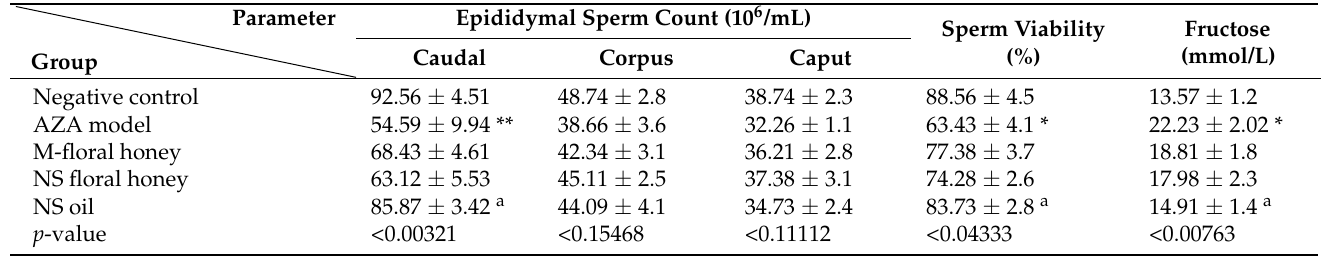
Table 6. Effects of M-floral honey, NS floral honey, and NS oil on sperm count, sperm viability, and